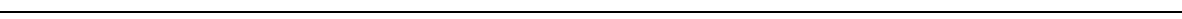
Fig. 2 Xist RNA, X-linked gene expression and H3K27me3 pro fi les in the ICM cells of early to late blastocyst stage embryos. a Examples of individual ICM analysed by immunolabelling with antibodies against H3K27 tri-methylation (grey scale) and combined with RNA-FISH for Xist RNA (green) and primary transcription from the X-linked genes (red), together with representative nucleus are shown (scale bar, 10 μ m). b Schematic representation of the X- chromosome showing the location of the loci analysed in a and c . Atp6ap2 gene is known to escape XCI in 60 – 80% of blastocyst cells 9 and used as a control of the experiment. c Percentage (mean) of cells showing biallelic expression for X-linked genes in ICM of independent early (E3.5), mid (E4.0) and late (E4.5) blastocyst stage embryos. d Examples of individual ICM analysed by immunolabelling with NANOG (grey scale), combined with RNA-FISH for Xist (green) and X-linked genes ( Atp7a and Kif4 ) (red) at early (E3.5) and mid (E3.75) blastocyst stage embryos. For each stage, an intact ICM (IF/RNA- FISH) and enlarged nuclei (white squares) are shown. Dotted lines indicate the position of NANOG-positive cells (scale bar, 10 μ m). e Proportion (mean) of NANOG-positive ICM cells showing different Xist and X-linked gene expression patterns at early (E3.5) and mid (E3.75) blastocyst stage embryos. Below the graph, the total cell number analysed is indicated, followed by the total number of female embryos analysed in brackets. f Proportion (mean) of NANOG-negative ICM cells showing different Xist and X-linked gene expression patterns at early (E3.5) and mid (E3.75) blastocyst stage embryos. Below the graph, the total cell number analysed is indicated, followed by the total number of female embryos analysed in